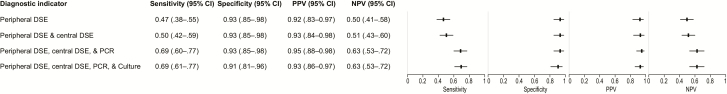
Incremental accuracy estimates. Abbreviations: CI, confidence interval; DSE, direct smear examination; NPV, negative predictive value; PCR, polymerase chain reaction; PPV, positive predictive value.